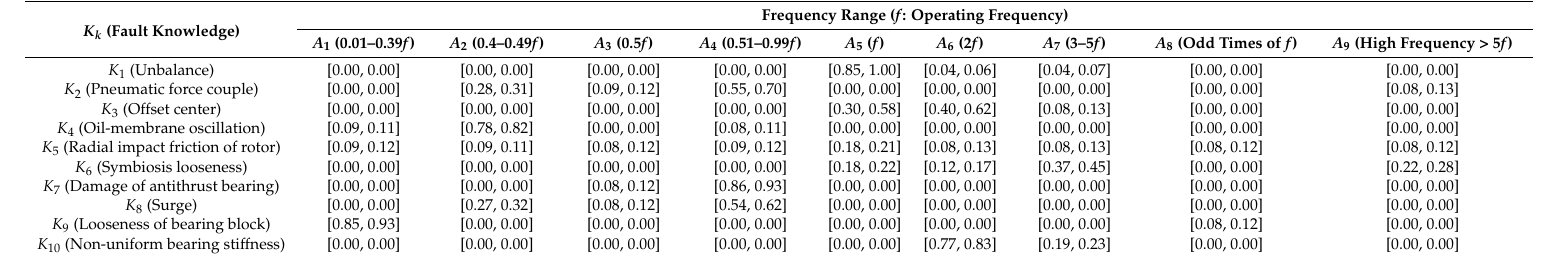
Table 5. Fault knowledge of steam turbine.